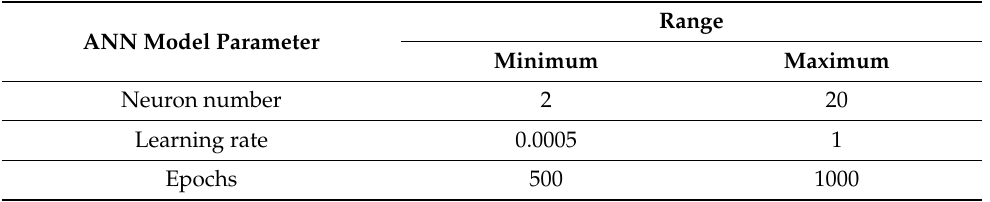
Table 3. The optimizing range for ANN model parameter.